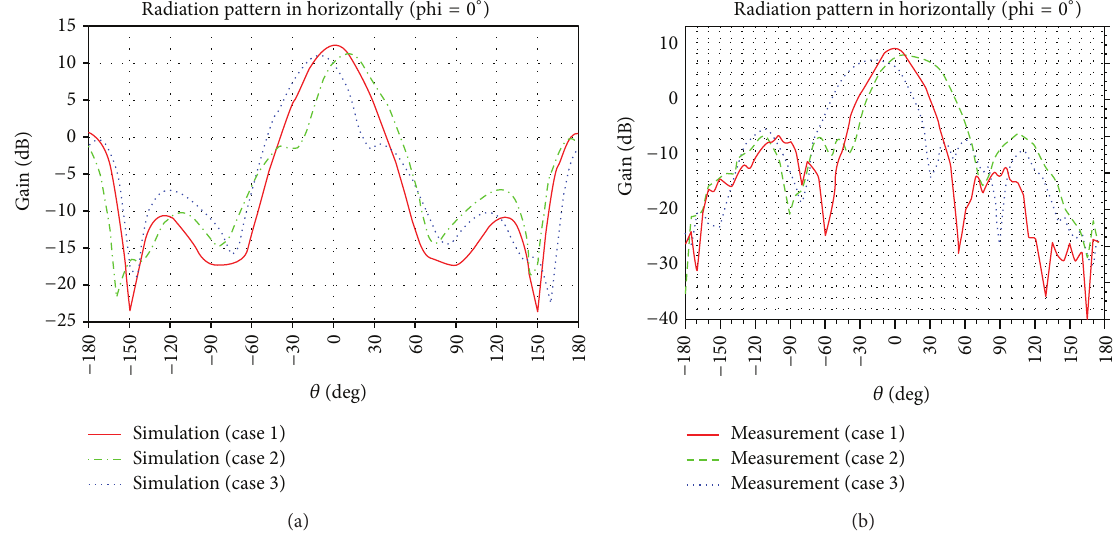
Figure 27: (a) Radiation pattern of FL-LHM beam steering antenna with ℎ = 30 mm in simulation. Beam steering horizontally; steering angles: − 10 ∘ (case 2), 0 ∘ (case 1), and 10 ∘ (case 3). (b) Radiation pattern of FL-LHM beam steering antenna with ℎ = 30 mm in measurement. Beam steering horizontally; steering angles: − 10 ∘ (case 2), 0 ∘ (case 1), and 10 ∘ (case 3).